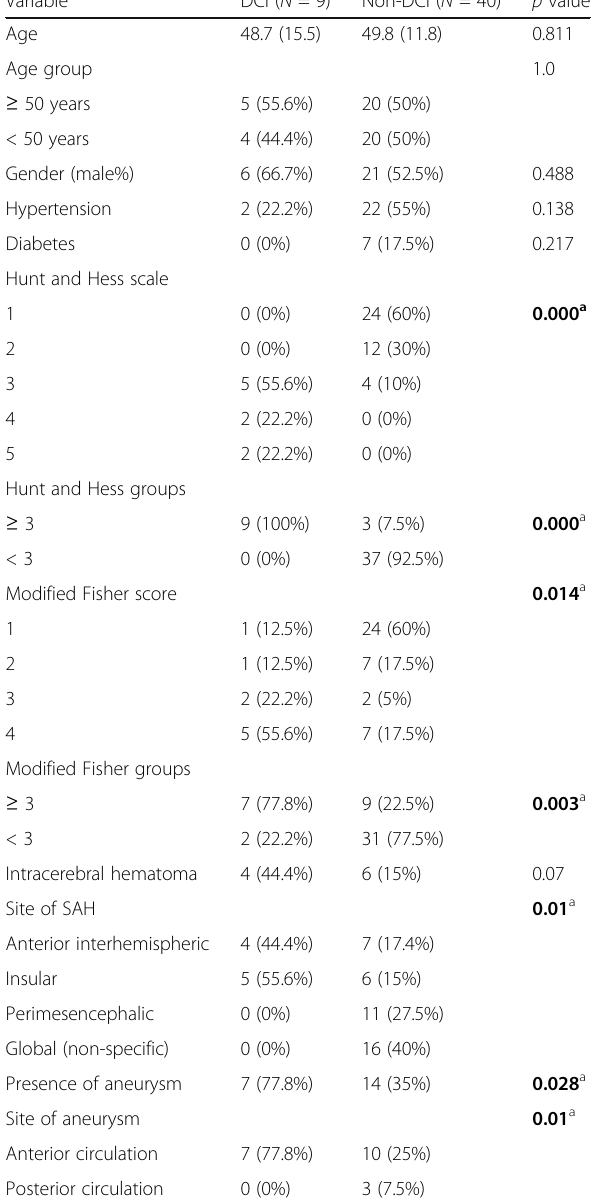
Table 1 Baseline demographics in the DCI and Non-DCI groups Table 2 Absolute and relative CTP values among patients with